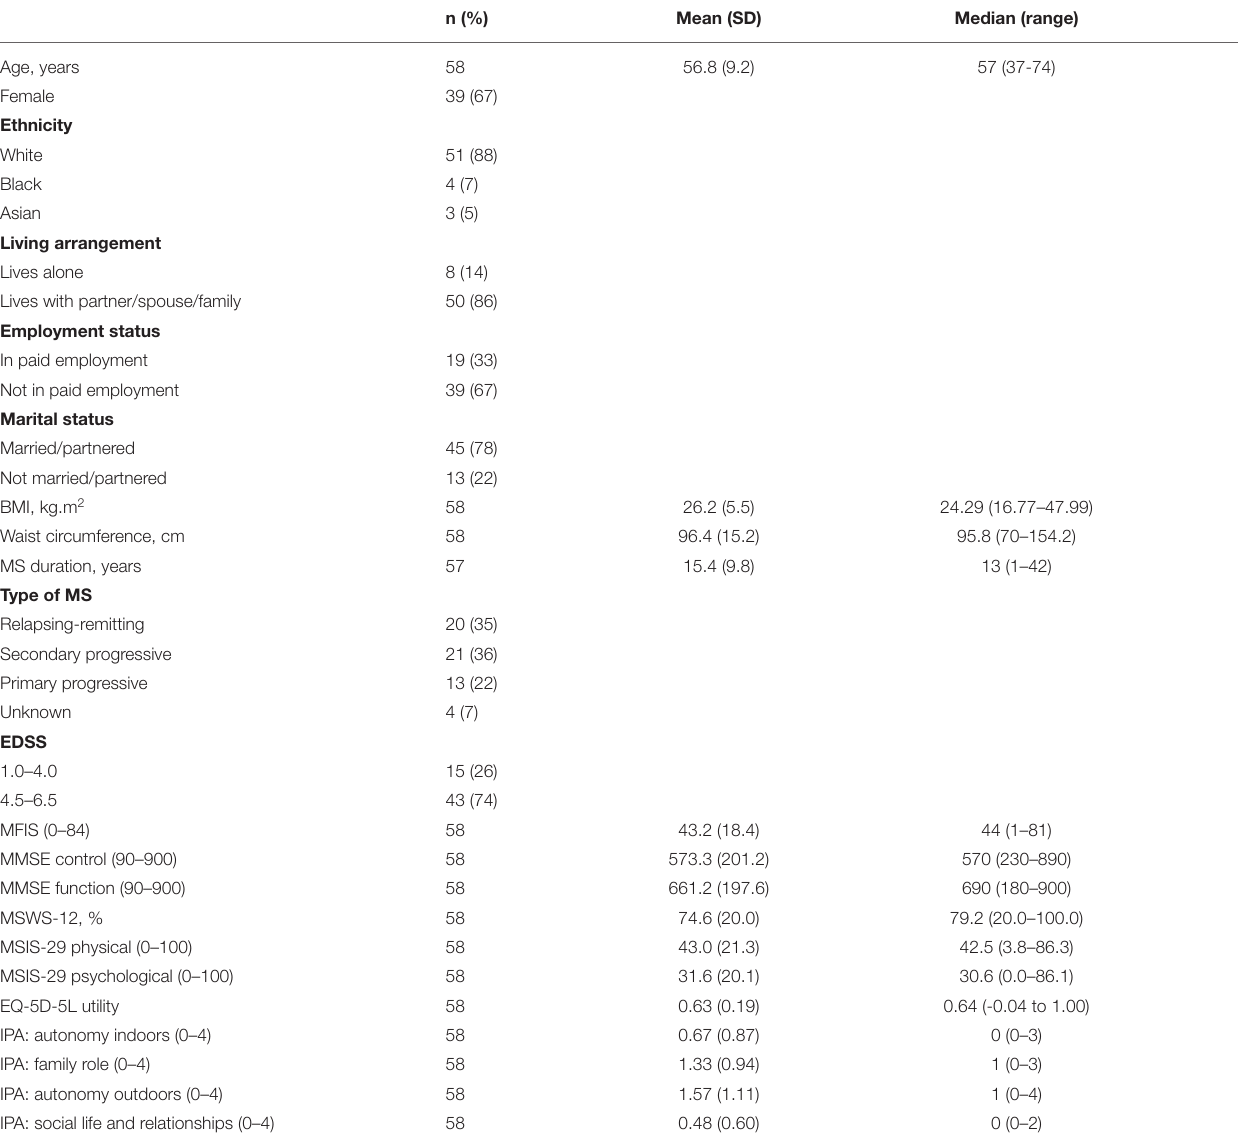
TABLE 1 | Participant